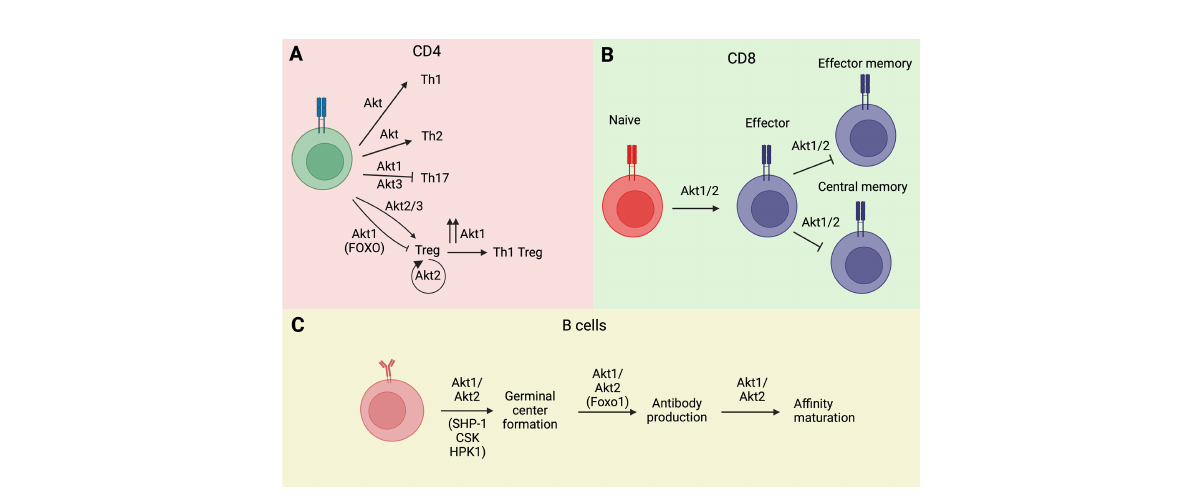
FIGURE 2 Akt isoforms regulate lymphocyte ontogeny and differentiation. (A) Akt1 and Akt3 isoforms modulate Th differentiation of CD4 Th cells. (B) Similarly, Akt1 isoform is implicated in memory phenotype acquisition in T CD8 + cells. (C) The activation of Akt1/Akt2 isoforms is essential for B cell ontogeny. Wherever known, the targets and/or transducers of Akt ’ s effects are indicated in parenthesis. Image created with